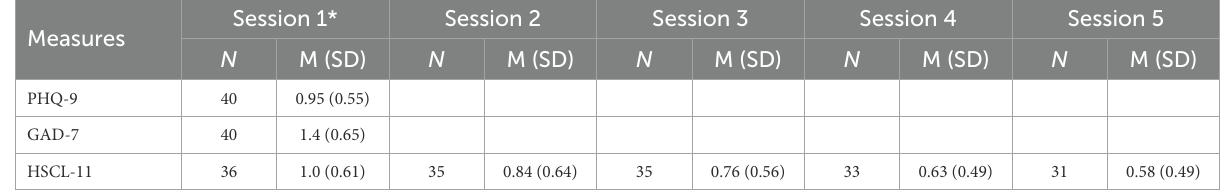
TABLE 3 Descriptive results of the total scores of depressive symptomatology (PHQ-9), anxious symptomatology (GAD-7) and severity levels of patients session-by-session (HSCL-11).